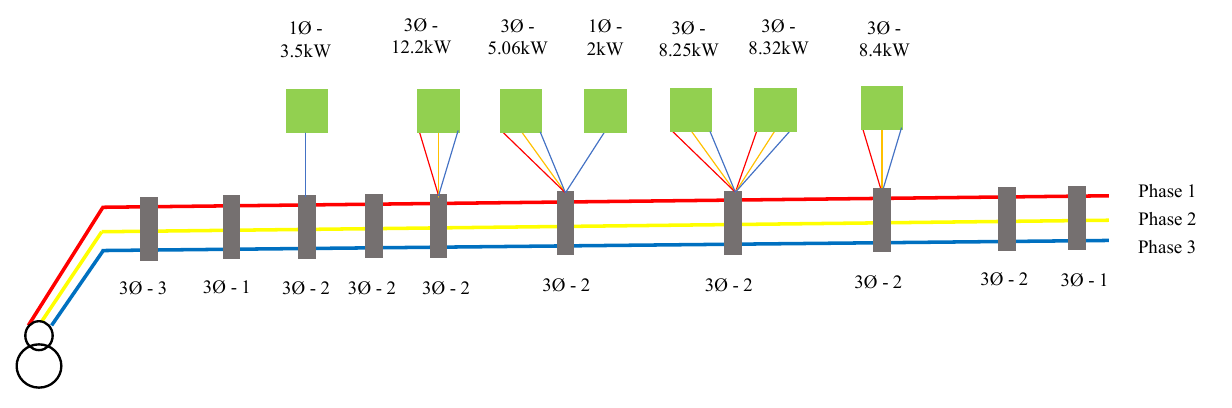
Figure 5: Schematic diagram of feeder